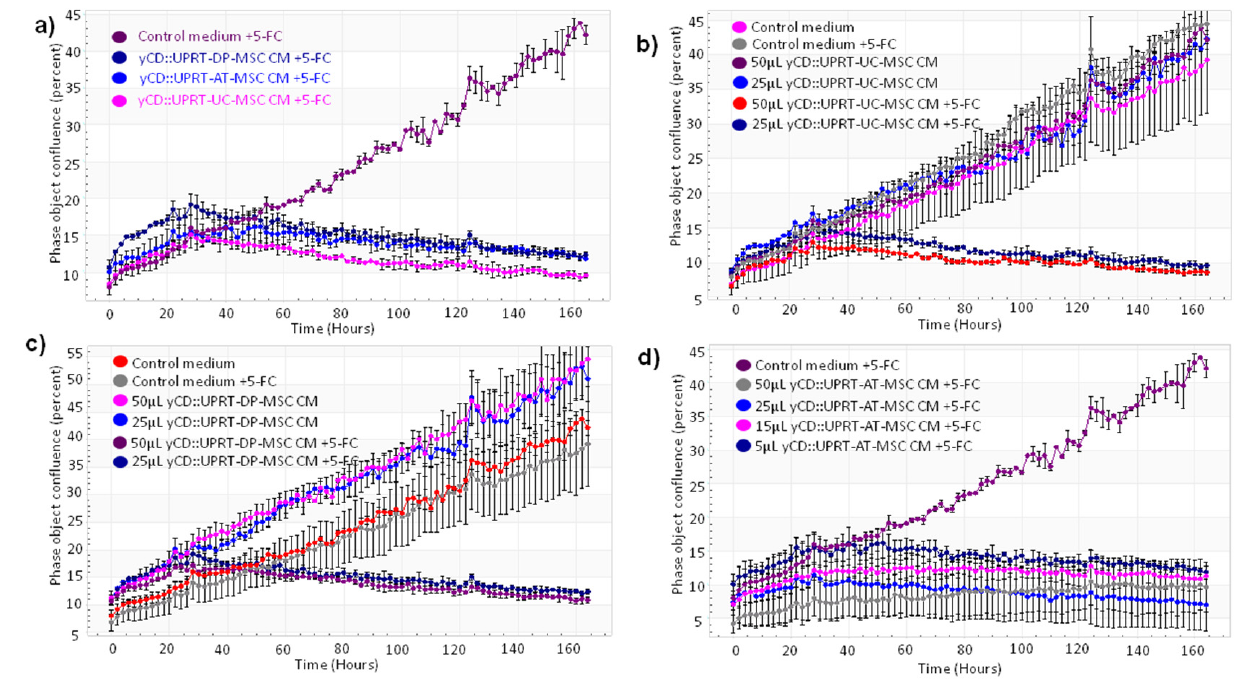
Figure 2. Growth curves of C6 glioblastoma cells treated with CM from various yCD::UPRT-UC- MSCs. The course of growth/inhibition was monitored by the IncuCyte system. The cell density was followed by image scanning of the culture every 2 h over 6 d. The standard deviation was calculated for each scan. ( a ) Growth inhibition of C6 cells with CM from yCD::UPRT-AT-MSCs, from yCD::UPRT-UC-MSCs, and from yCD::UPRT-DP-MSCs in the presence or absence of 5-FC. ( b ) Growth curves of HPGC cultivated in vitro and treated with CM from yCD::UPRT-UC-MSCs in the absence or presence of 5-FC. ( c ) Growth inhibition of HPGC treated with CM from yCD::UPRT-DP-MSCs in the presence or absence of 5-FC. ( d ) Growth inhibition of HPGC treated with CM from yCD::UPRT-AT-MSCs in the presence or absence of 5-FC. 5-FC, 5-fluorocytosine; CM—conditioned medium; HPGC—human primary glioblastoma cells.